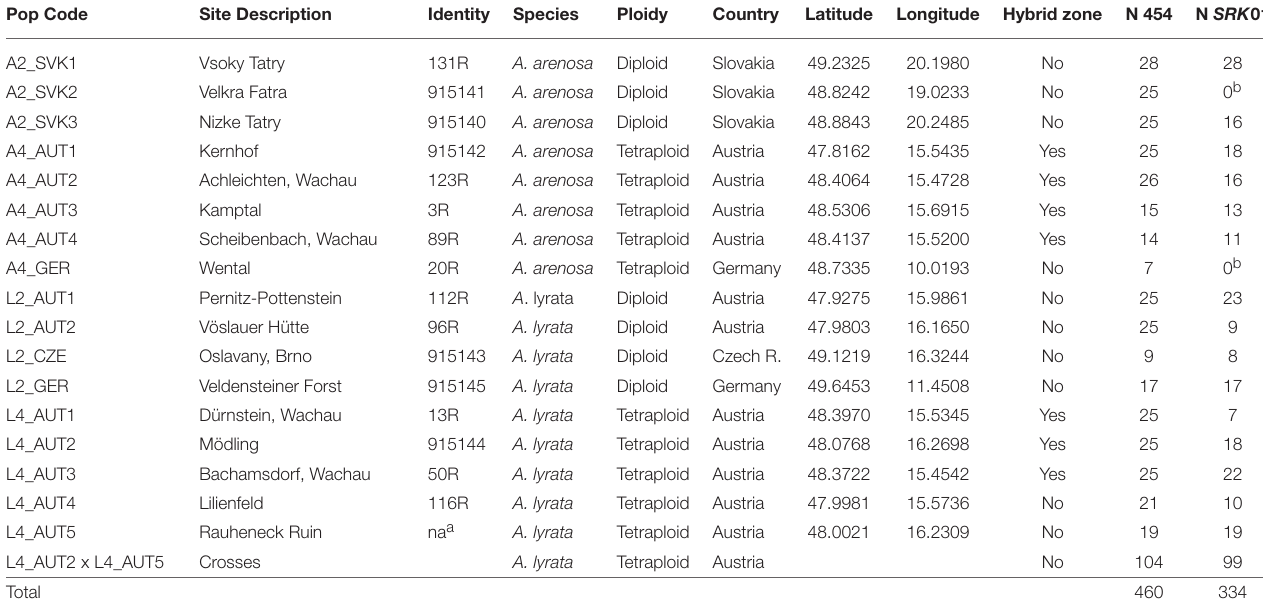
TABLE 1 | Populations sampled, indicating the code (Pop Code) used to identify populations in our study, the population identifier (identity) from Schmickl (2009), site description, ploidy, species, country of origin, GPS coordinates (latitude and longitude), and whether the population is in the known hybrid zone in Austria, as well as sample sizes for the 454 pyrosequencing (N 454) and targeted amplicon sequencing of SRK 01 (N SRK